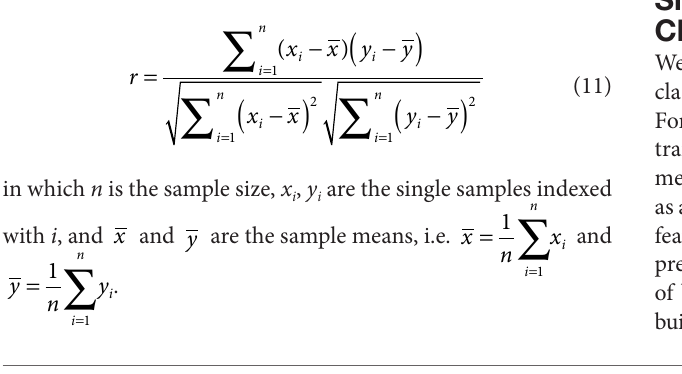
TABLE 1 | Selected features to predict protein-RNA binding affinity of each class of protein-RNA